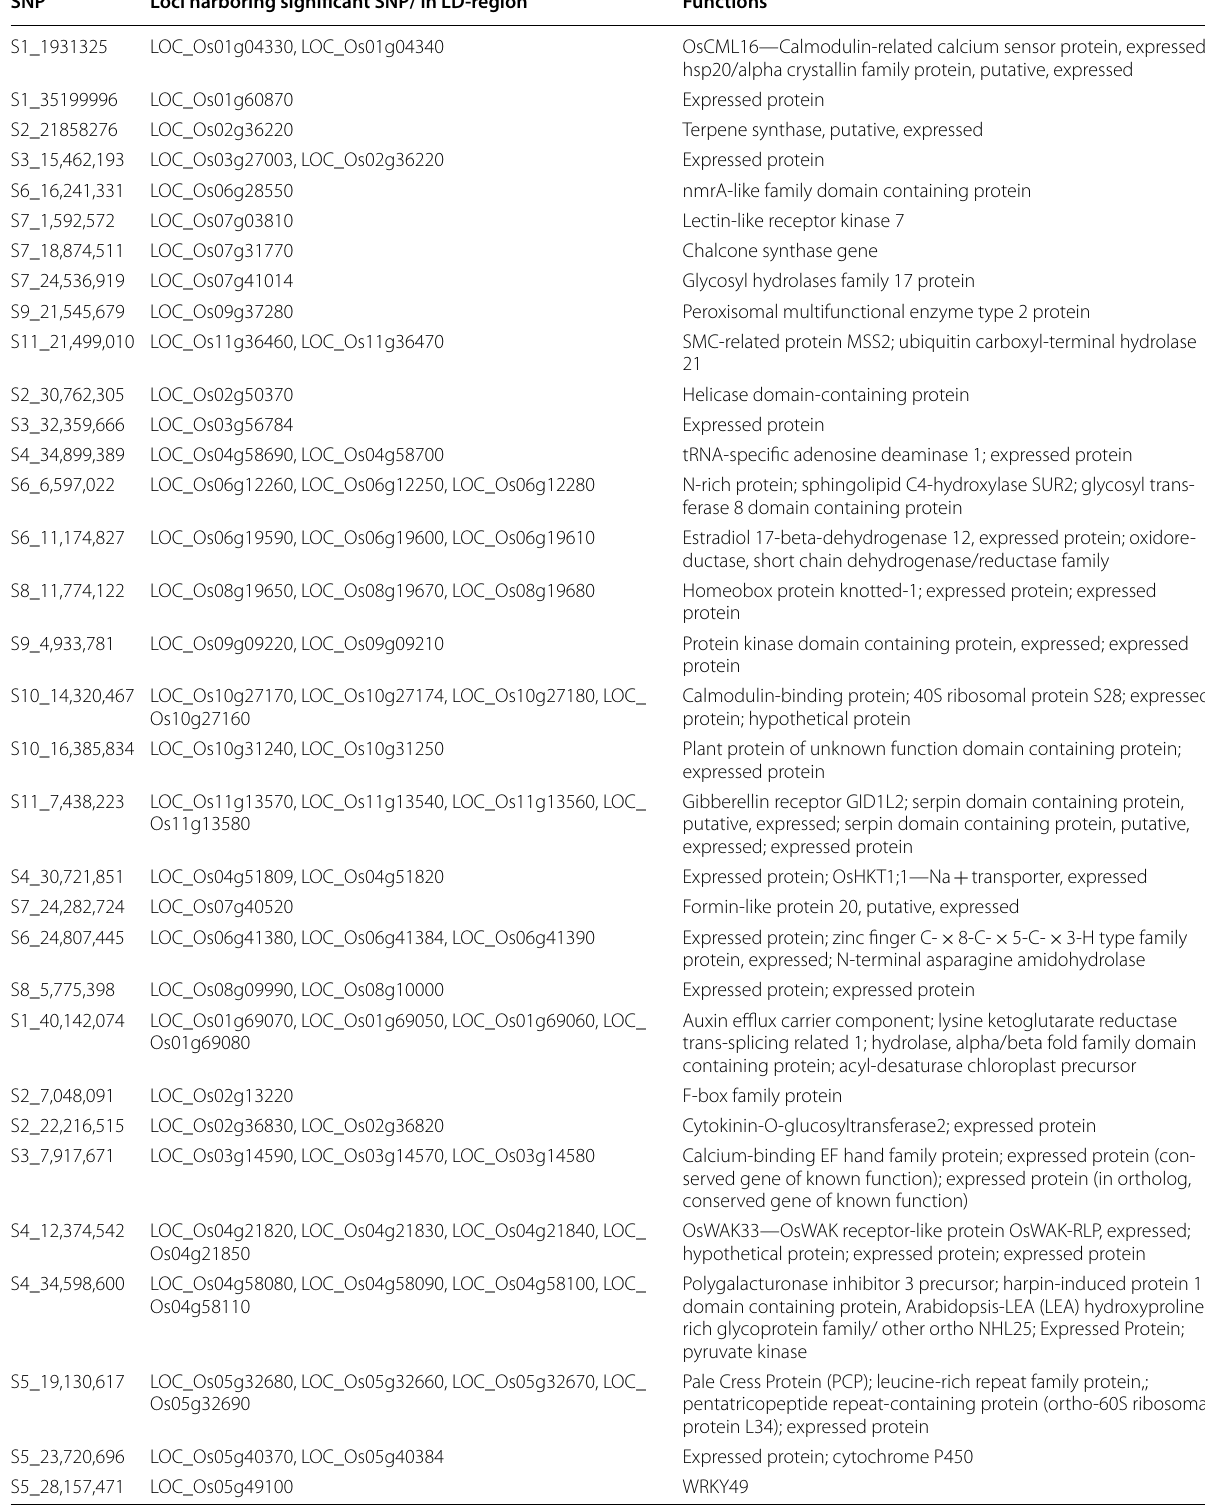
Table 4 Functional annotation of loci harboring significant SNPs/ present in LD-region of significant SNPs SNP Loci harboring significant SNP/ in